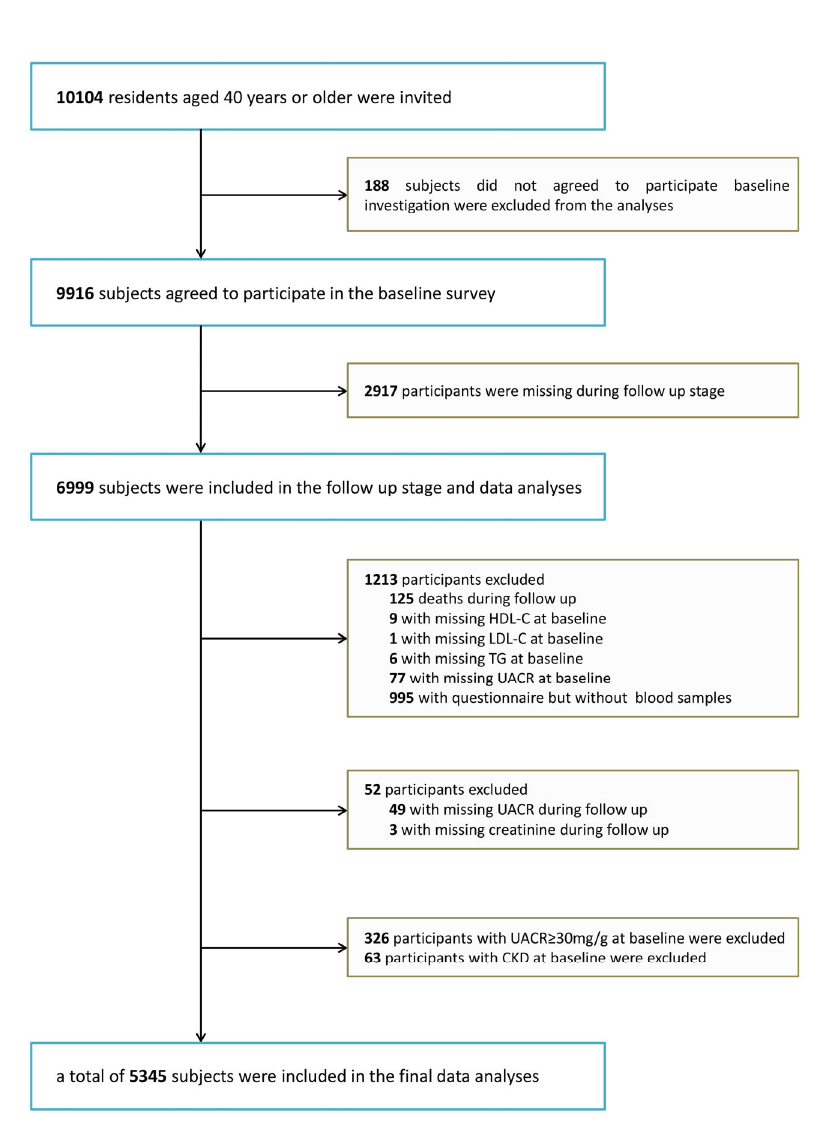
Figure 1. Flowchart of the population selection of the study.HDL‑C, high‑density lipoprotein choles‑terol; LDL‑C, low‑density lipoprotein cholesterol; TG, triglycerides; UACR, urinary albumin‑to‑creatinine ratio; CKD, chronic kidney disease.